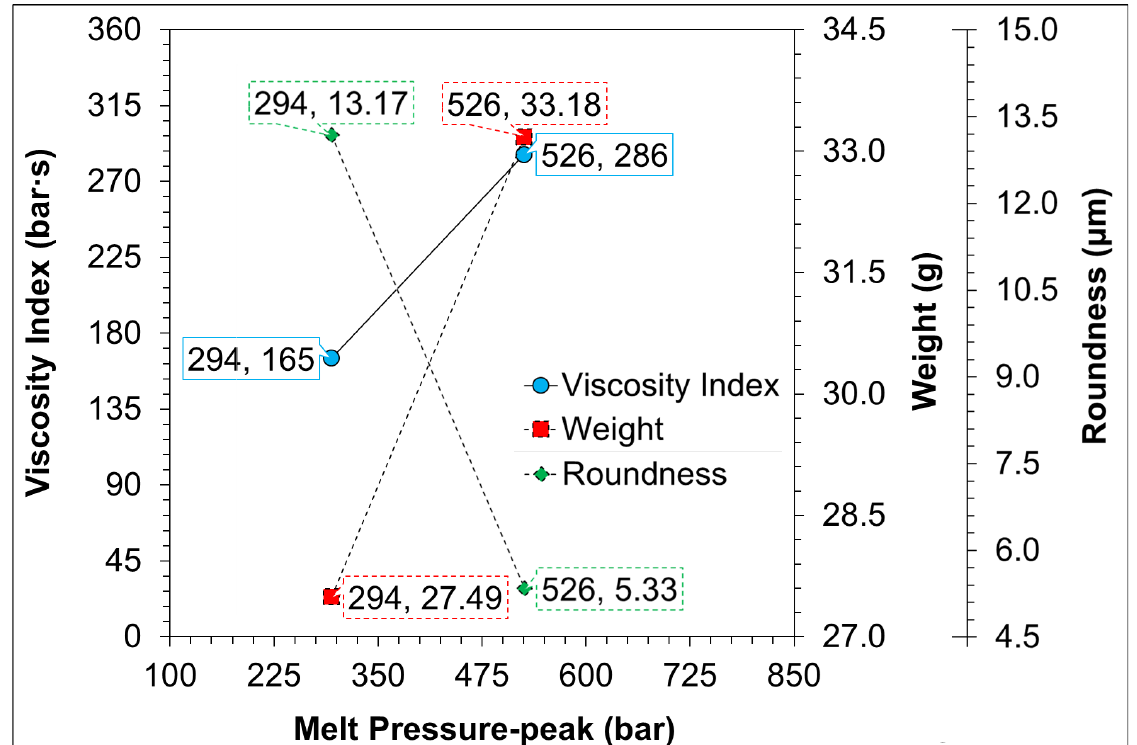
Figure 10. Effect of different materials on melt pressure-peak ( x -axis) and viscosity index (continuous-line) on the barrel and its sample weight/roundness (short-dash-line/chain-line) ( y -axis); the melt pressure peak is 294 bar for PP and 526 bar for PS.